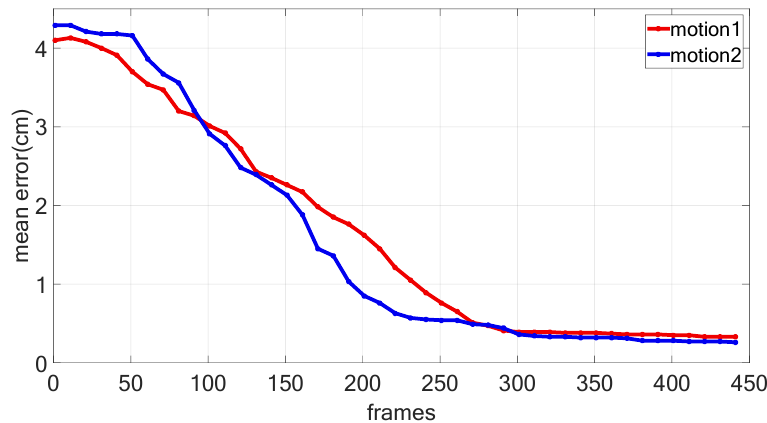
Figure 13. The average reconstruction error between the model and KinectFusion. The horizontal ordinate represents the number of frames processed. The vertical coordinate represents the average reconstruction error. The average reconstruction error decreases along with the increase of